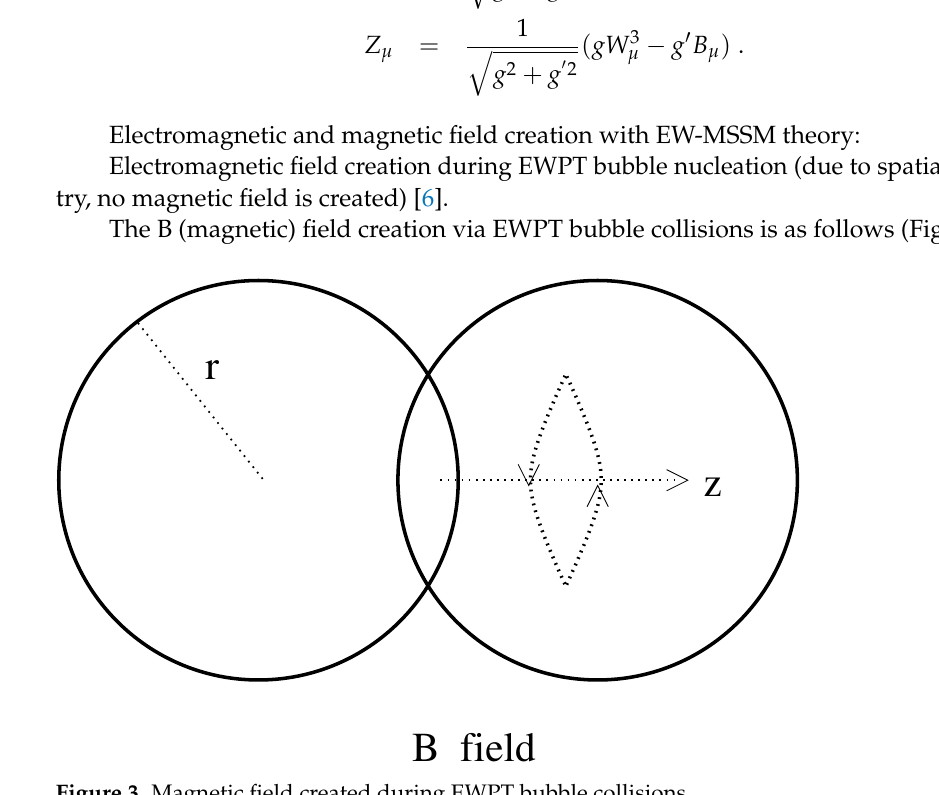
Figure 3. Magnetic field created during EWPT bubble collisions. Results for B (magnetic) field creation [7] via EWPT [8] bubble collisions (Figure 4):